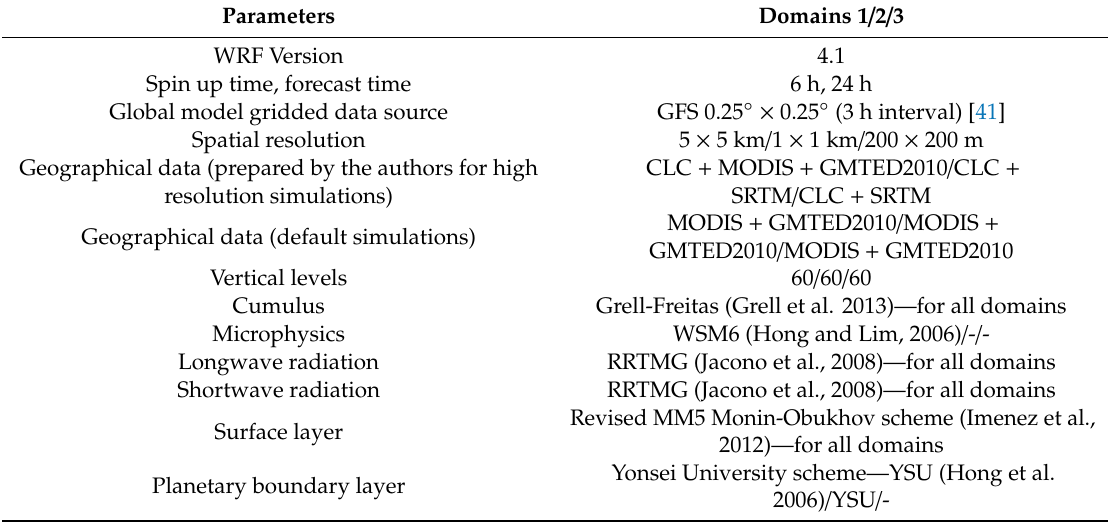
Table 2. The WRF model configuration used in the